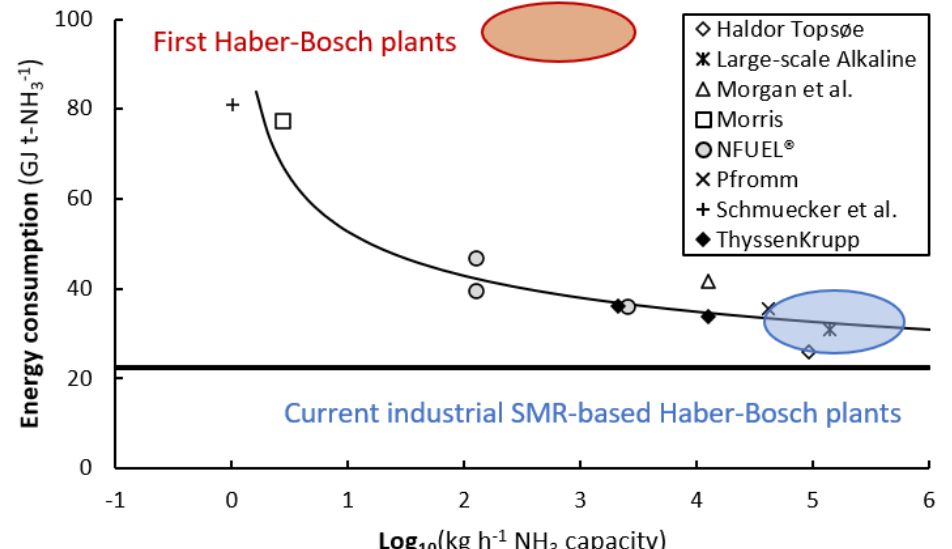
Figure 1. Energy consumption of electrolysis-based Haber-Bosch processes as function of ammonia production capacity. Adapted and modified from [16]. Original references [17–26]. One microwave (MW) corresponds to approximately 100 kg h −1 ammonia.